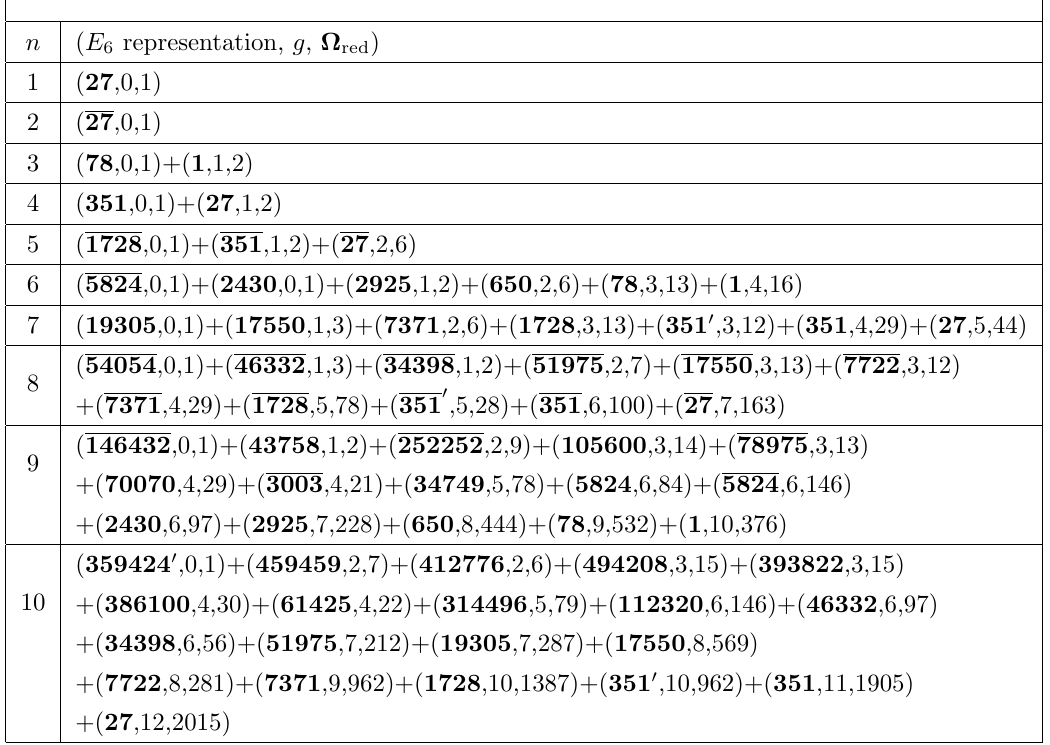
Table 1 . The allowed representations for BPS states with asymptotic charges n (1 ; 0), with 1 (cid:20) n (cid:20) 10, are listed. We also list the genus of the corresponding holomorphic curves, and the reduced index (cid:10) red computed in [37, 38]. We follow [45] for the R , R and R 0 conventions.